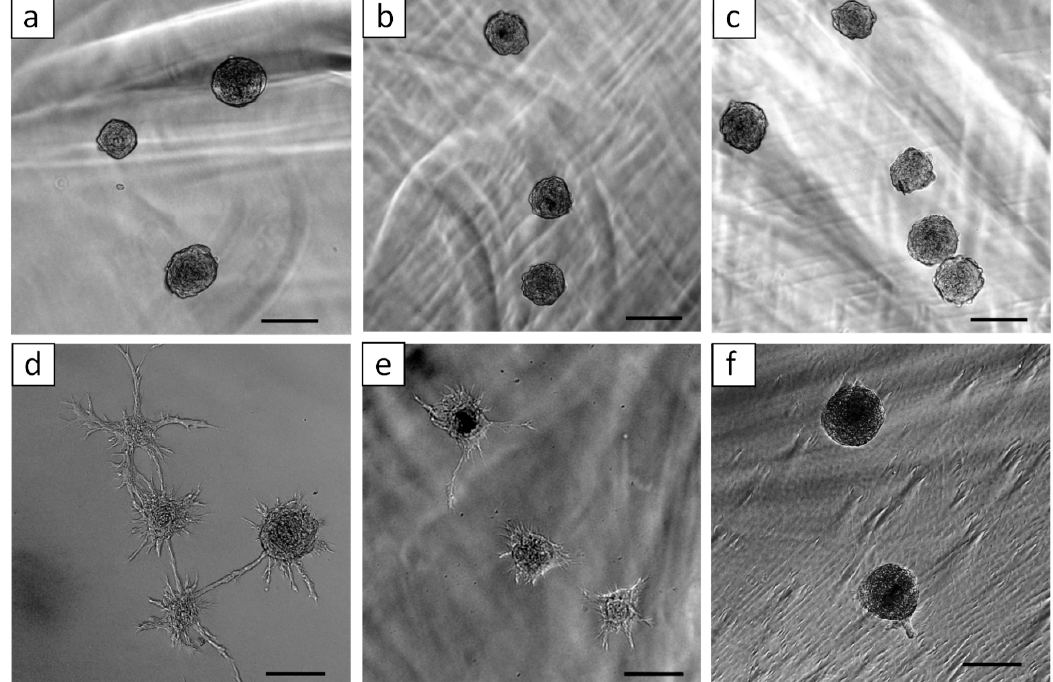
Figure 4. Three-dimensional in vitro angiogenesis of HUVEC spheroids in the different concentrations of GelMA (( a , d ) 5%, ( b , e ) 7.5%, and ( c , f ) 10%) just after polymerization of GelMA ( a – c ), and after 1 day of culture ( d – f ). Bars = 100 μ m.